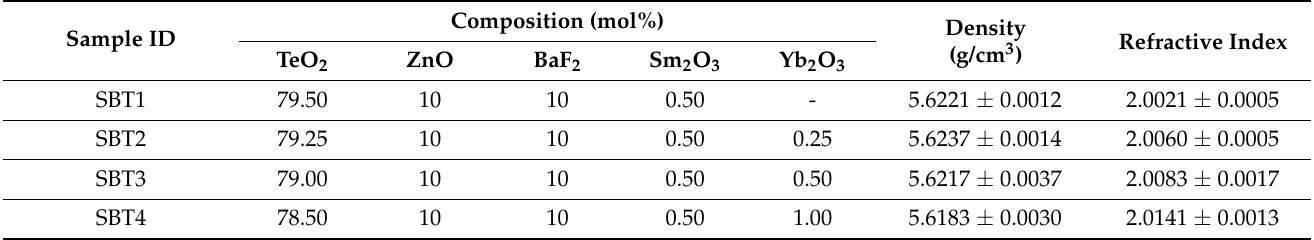
Table 1. Molar composition, density, and refractive index of the Sm 3+ /Sm 3+ :Yb 3+ -doped barium fluorotellurite glass